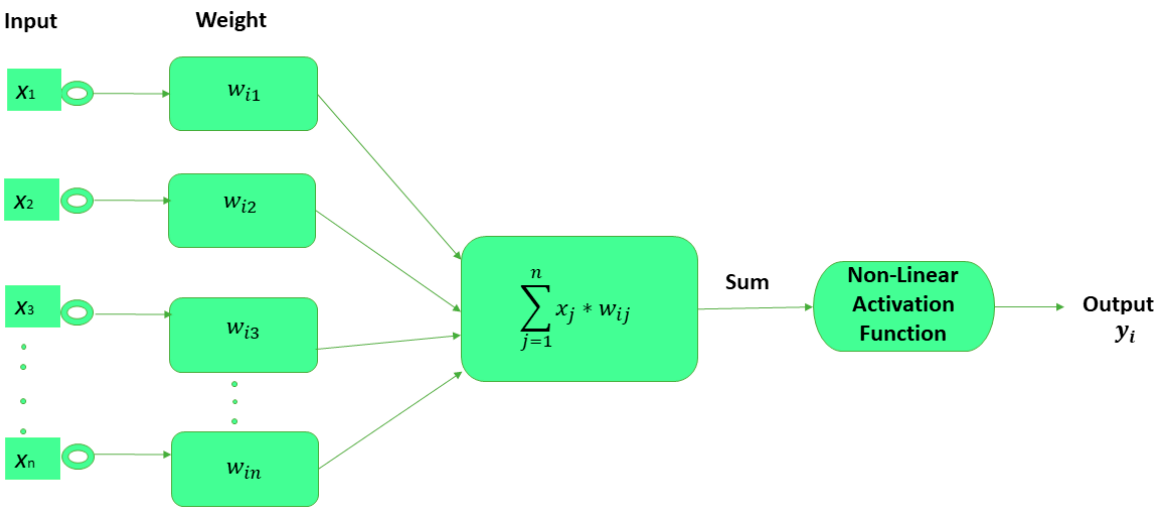
Figure 2. Representation of a basic neural network (NN).